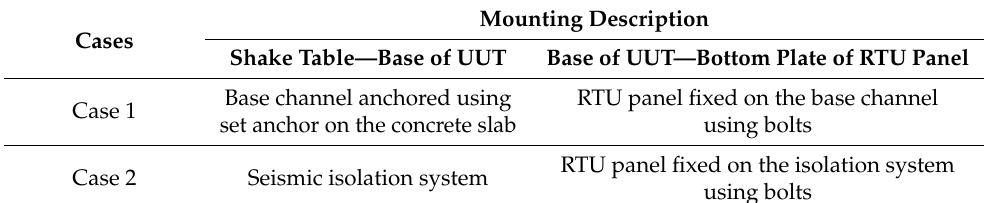
Table 2. Detailed description of shaking table tests.